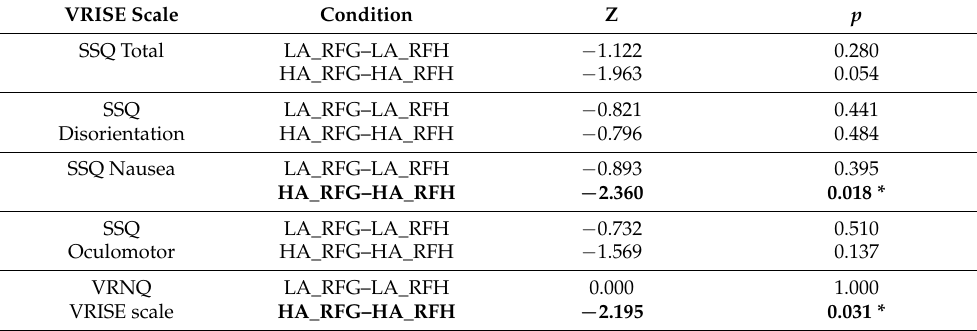
Table 17. Wilcoxon signed-rank test for VRISE scores between rest-frame conditions for participants who had normal vision and did not use distance spectacles or contact lenses.